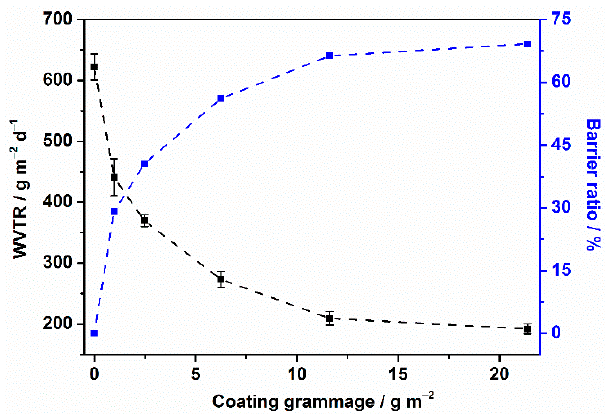
Figure 7. WVTR value and barrier ratio of the CUE-coated papers as a function of the coating grammage.